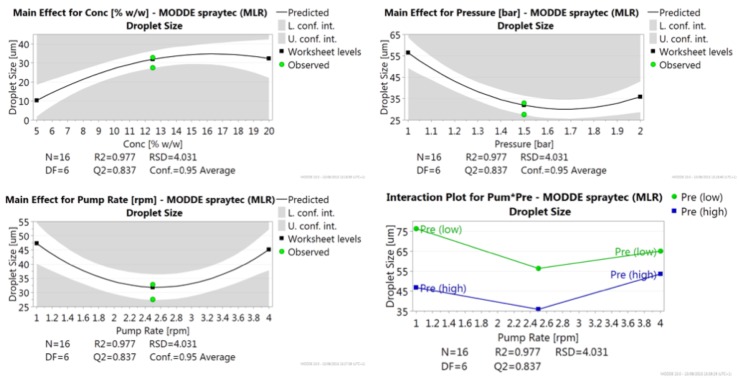
Main Effect Plots for concentration, atomisation pressure and pump rate on droplet size.Bottom right, Interaction Plot for the interaction between pump rate and atomisation pressure. The two lines show atomisation pressure at the low level (1 bar) and high level (2 bar).